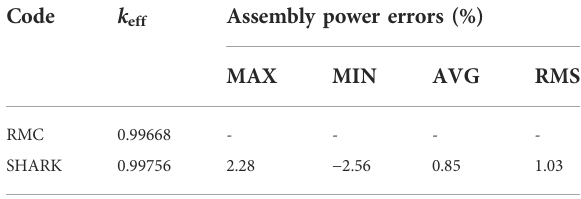
TABLE 3 Calculation results of HuaLong whole-core